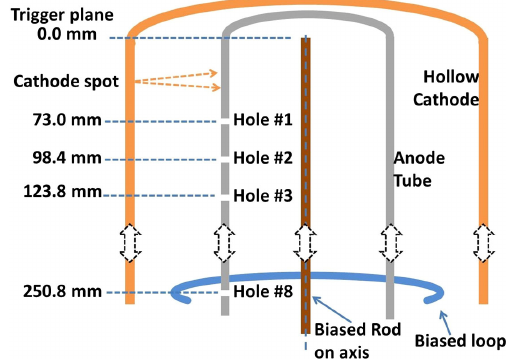
FIG. 2. Schematic of a section of the v z measurement arrange- ment in the HEC-CED